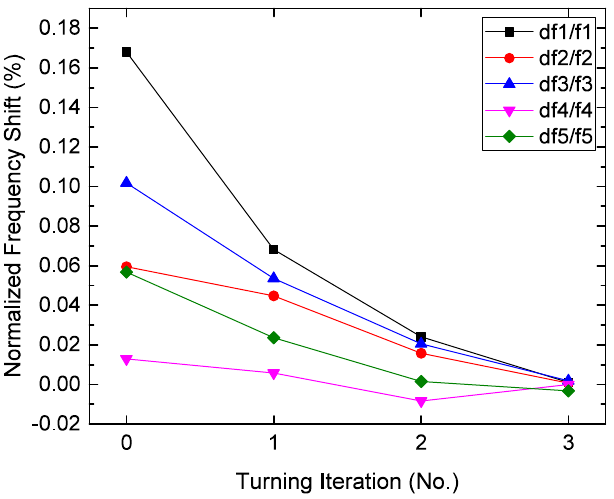
FIG. 14. Tuning process to achieve the target frequencies by solving the tuning matrix equation and adjusting the stub tuners three times in the